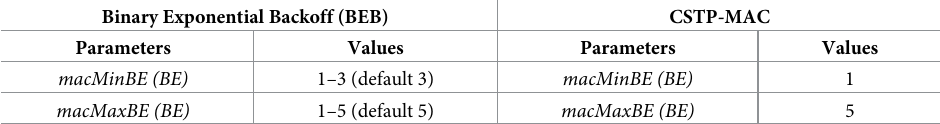
Table 2. Backoff Exponential (BE) parameters for BEB and CSTP-MAC for slotted CSMA/CA.